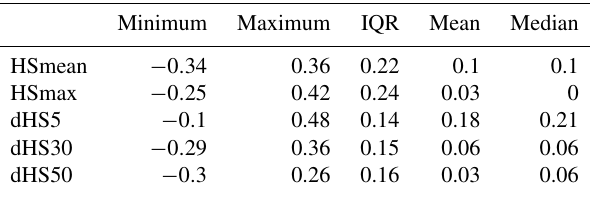
Table 1. Summary of autocorrelations for lag (year) 1 for all stations ( n =